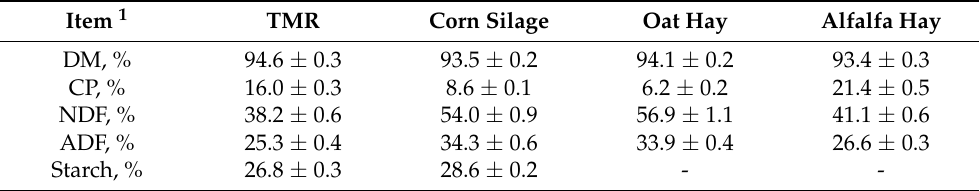
Table 2. Chemical composition of total mixed ration and feedstuffs used in vitro (dry matter